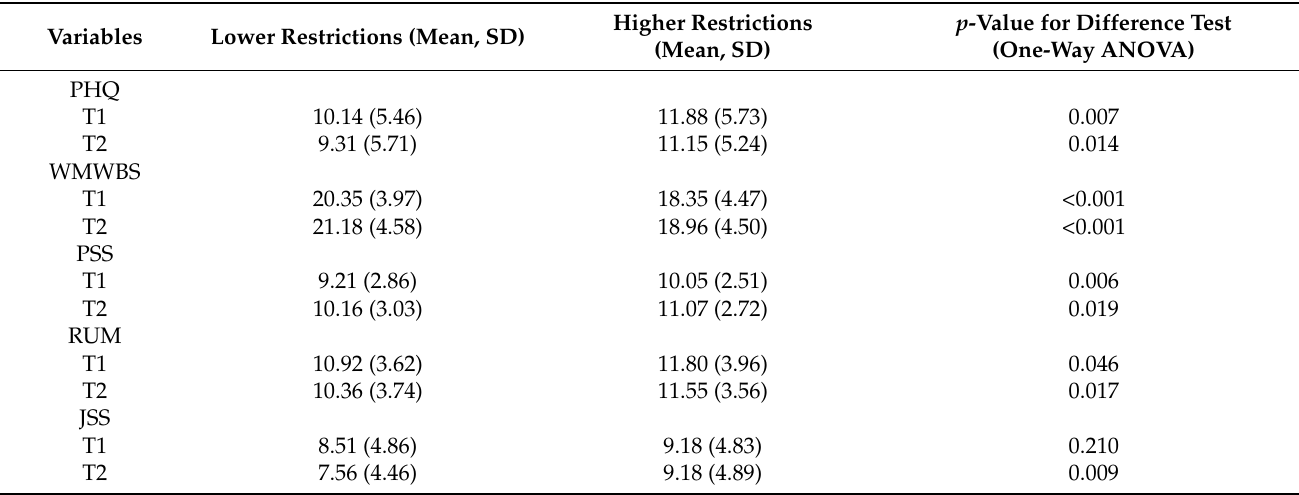
Table 2. Means and standard deviations for the five wellbeing measures at T1 and T2, by lockdown restriction severity